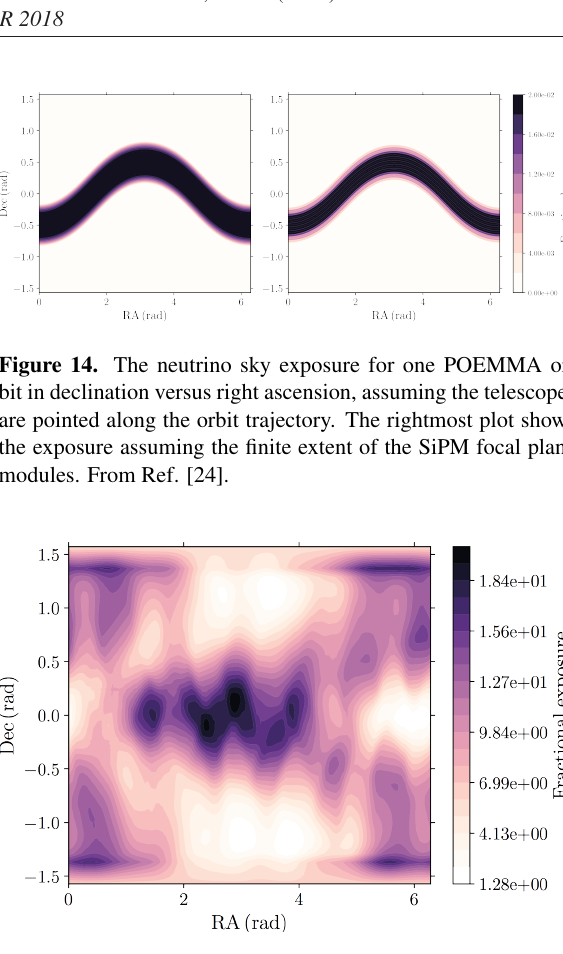
Figure 15. The fractional neutrino sky exposure for one year in declination versus right ascension, assuming a defined varia- tion in the POEMMA limb-pointing directions over the year to achieve full-sky coverage. The calculation takes into account the e ff ects of the sun and moon on the duty cycle for observations. From Ref.